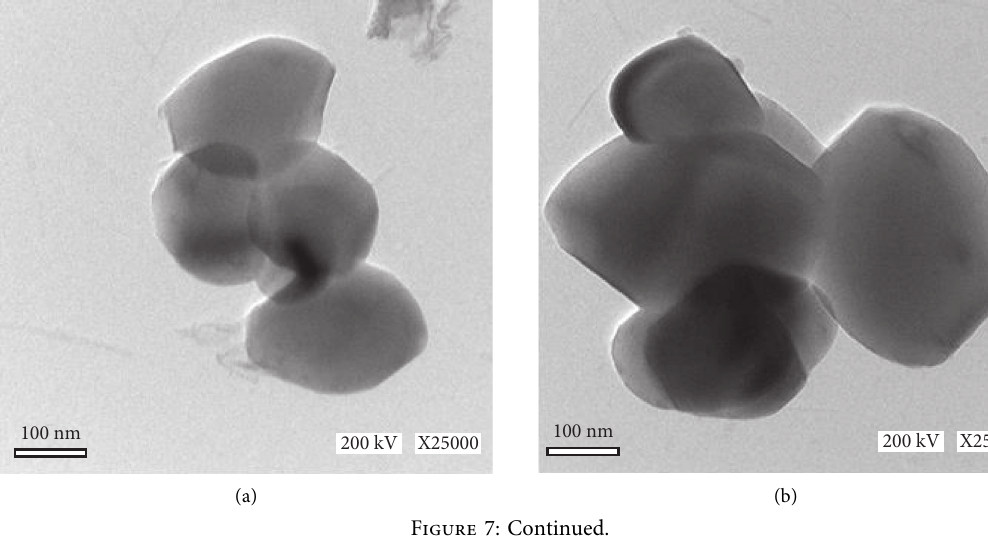
Figure 6: SEM micrograph of (a) gypsum, (b) Ca(OH) calcination at 1000 °